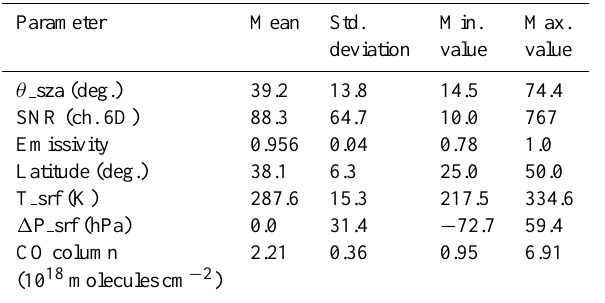
Table 1. Non-pressure-dependent parameters for MOPITT CO AK multiple regression f (2006 CONUS data sample, all seasons, num- ber of scenes in training set=15952).